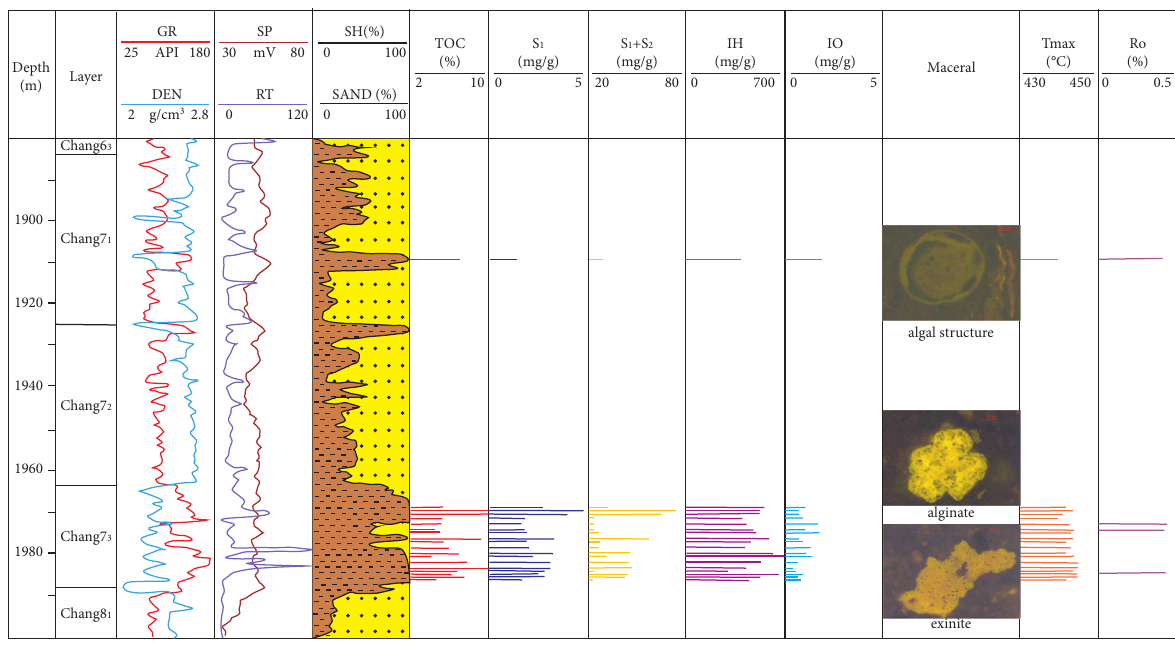
Figure 4: The comprehensive geochemical profile of well G43.